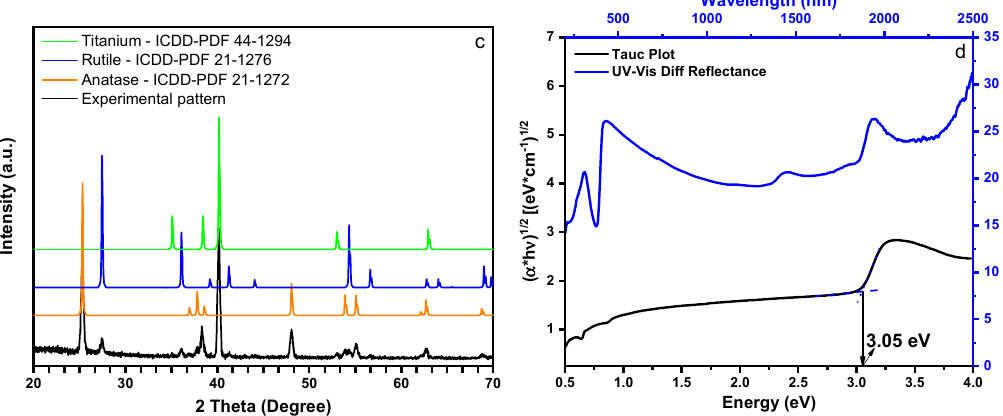
Figure 1. SEM micrographs, the left insets show a magnified SEM cross-section image and the EDX spectrum ( a ); Nyquist plot and fitting equivalent circuit (inset) ( b ); XRD pattern of the TiO 2 catalyst (experimental pattern) and the reference spectra for Anatase; Rutile; and Titanium ( c ); UV-VIS reflectance spectra (right and upper axes) and corresponding Tauc plot (left and lower axes) ( d ).